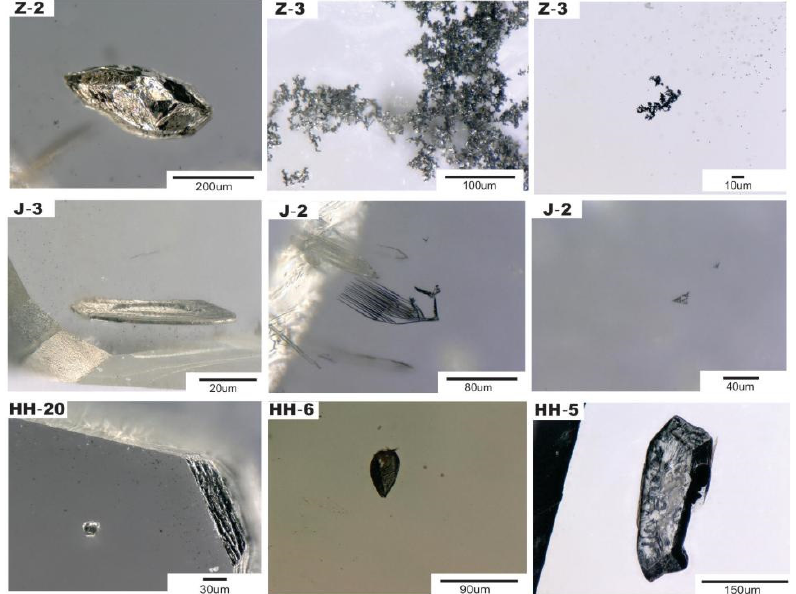
Figure 3. The inclusions in Chinese HPHT synthetic diamonds collected from factories Z, J and HH. The first row : Rod-like, lichenoid (tree-like) and fine-point-like inclusions from factory Z, {100}; The second row : Disc shape, tubular and kite-like inclusions, {111}, from factory J; The third row : Pear or water-drop inclusions, fine-point-like and rod-like inclusions, {111}, from factory HH. These samples were produced in 2017–2020. Photographs by Ying Ma and Xu Ye.